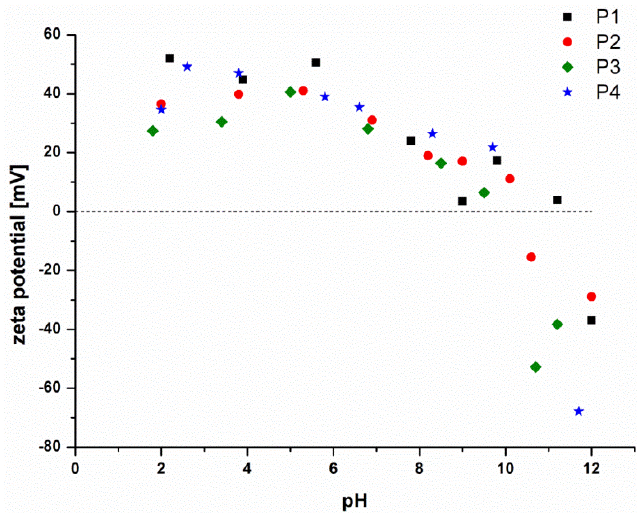
Figure 6. The zeta potential changes as a function of pH for P(DMAEMA- co -OEGMA-OH) stars. (c = 1 mg/mL, 25 °C).